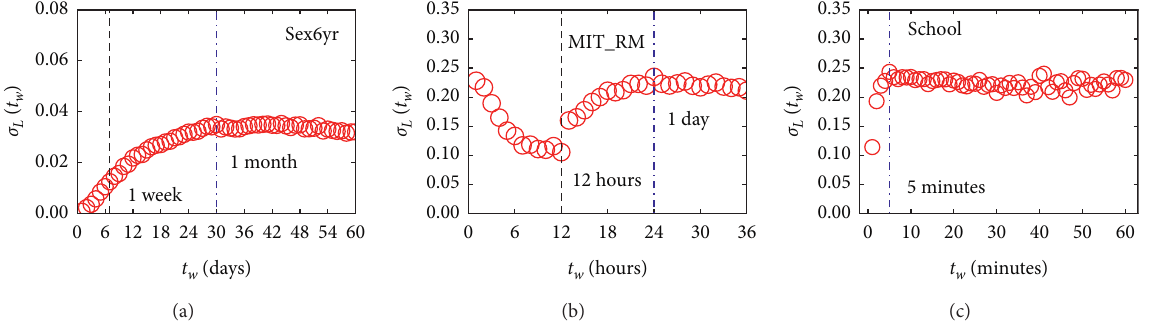
Figure 10: The average correlation as a function of the time window t